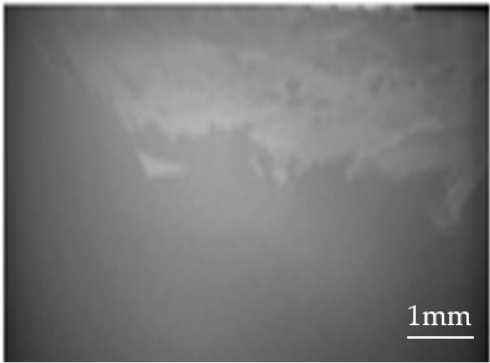
Figure 8. Infrared image of silicon crystal.